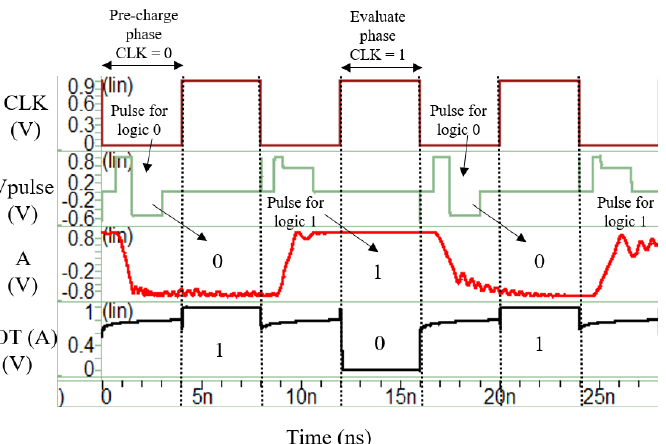
Figure 4. Transient response of logic operation NOT where CLK is the input clock pulse, Vpulse is the shaped voltage pulse that is used to switch the state of MTJ, A is input logic values, and NOT (A) is the logical not values.